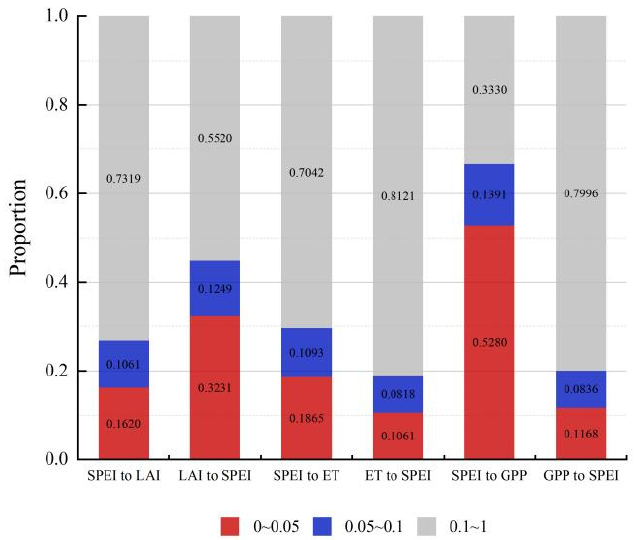
Figure 6. The proportion of pixels at different significance levels in Granger causality of four variables. The spatial distribution of the causality between SPEI and GPP was not